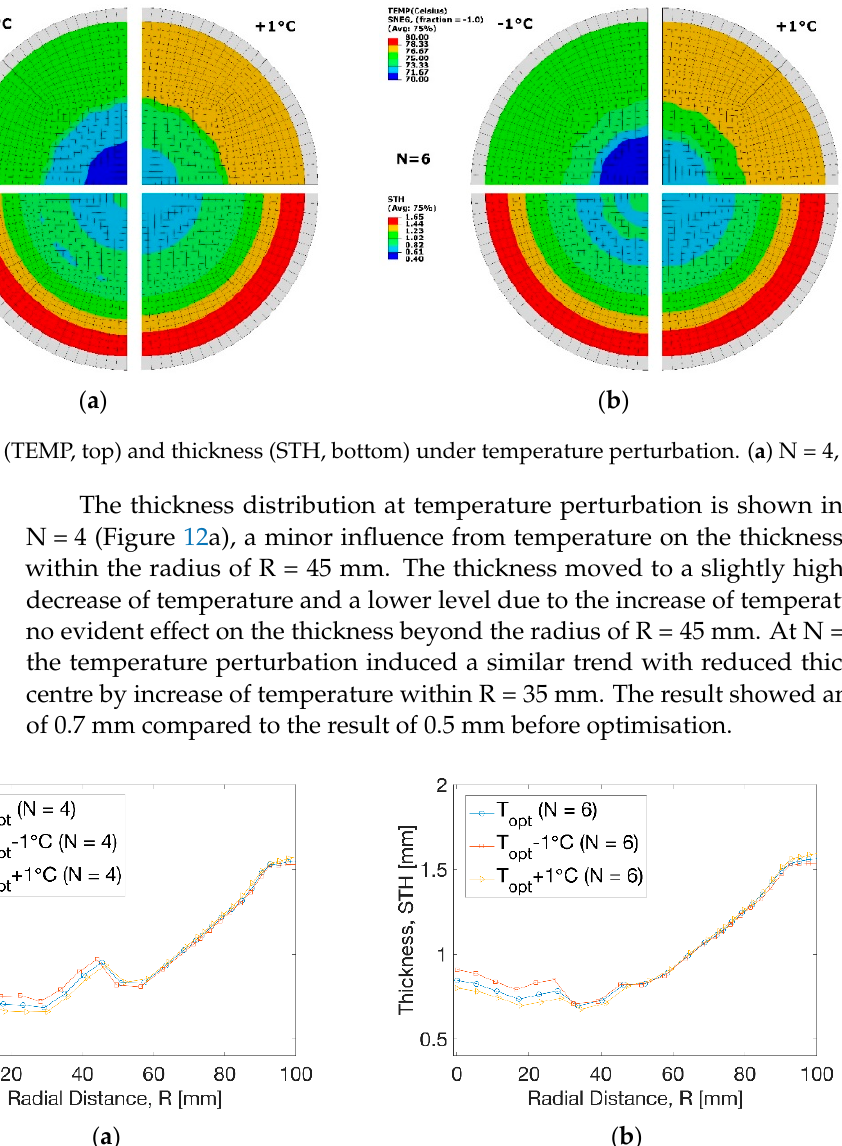
Figure 10. Strain distribution at different processing conditions. ( a ) Hoop strain, ( b ) axial strain.